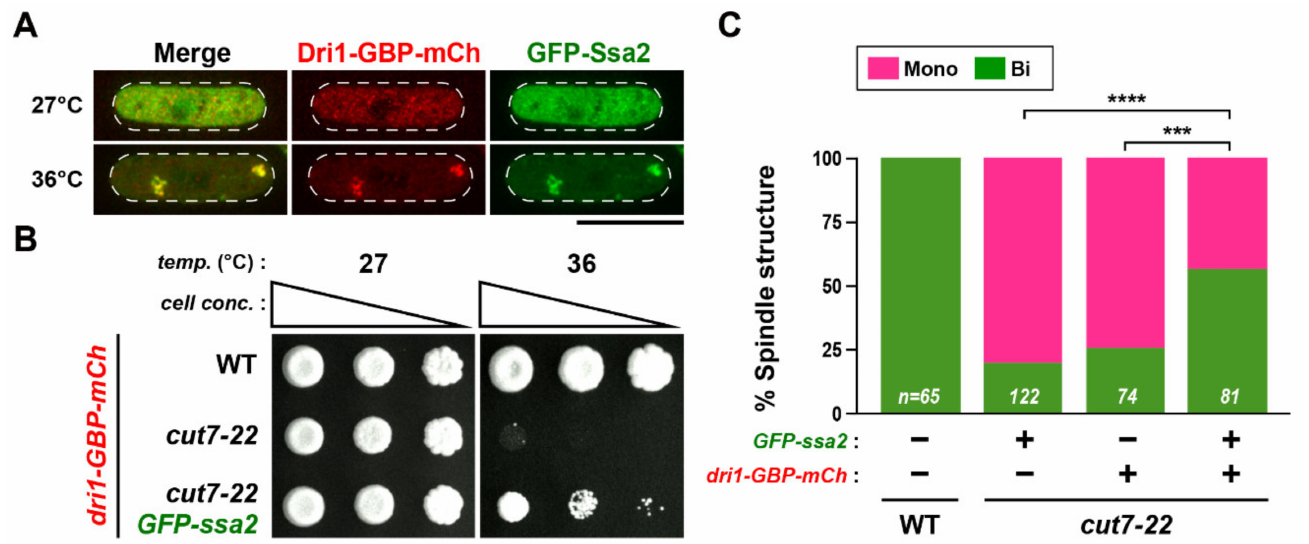
Figure 5. Forced tethering of Dri1 to PACs is sufficient to rescue cut7-22 . ( A ) Visualization of Dri1-GBP-mCherry localization in strains in the presence of GFP-Ssa2. Indicated strains were grown at 27 ◦ C and then shifted to 36 ◦ C for 2 h. The cell peripheries are indicated with dotted lines. Scale bar, 10 µ m. ( B ) Spot test. Indicated strains were serially (10-fold) diluted, spotted onto rich YE5S plates and incubated at 27 ◦ C and 36 ◦ C for 5 d. ( C ) cut7-22 cells containing Dri1-GBP-mCherry alone, GFP-Ssa2 alone or both were grown at 27 ◦ C and shifted to 36 ◦ C for 2 h. The percentage of cells with either mono- (magenta) or bipolar spindles (green) was counted. For comparison, the data for wild-type cells grown under the same condition are also shown. The sample numbers (n) for individual strains are indicated on the bottom of columns. All p -values were obtained from the two-tailed χ 2 test. ***, p < 0.001, ****, p <